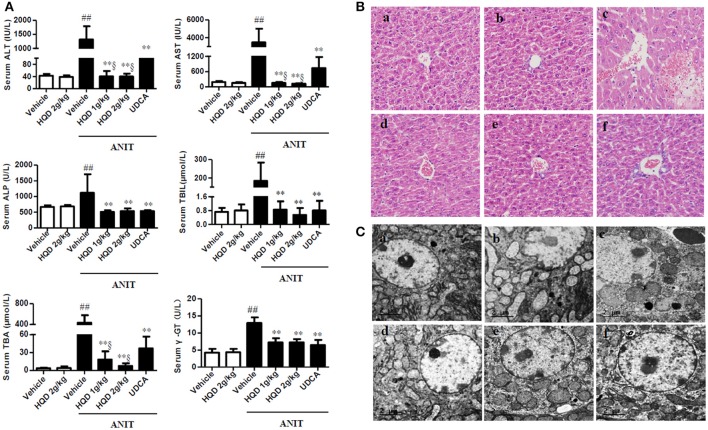
Huangqi decoction (HQD) protects against alpha-naphthylisothiocyanate (ANIT)-induced intrahepatic cholestasis in mice. (A) Serum biochemical parameters (B) Liver morphology was observed using light microscopy (original magnification, ×200) and (C) microstructure was observed using electron microscopy (scale bar, 2 μm, original magnification × 6,000). Groups: a, Vehicle; b, HQD 2 g/kg; c, ANIT + Vehicle; d, ANIT + HQD 1 g/kg; e, ANIT + HQD 2 g/kg; f: ANIT + UDCA. Data are means ± SD, n = 10 for serum biochemical parameters and light microscopy and n = 3 for electron microscopy; ##p < 0.01 and **p < 0.01 compared with Vehicle and ANIT + Vehicle groups; §p < 0.01 compared with the UDCA group. ANIT, alpha-naphthylisothiocyanate; ALT, alanine aminotransferase; AST, aspartate transaminase; ALP, alkaline phosphatase; TBA, total bile acid; TBIL, total bilirubin. γ-GT, γ-glutamyl transpeptidase.